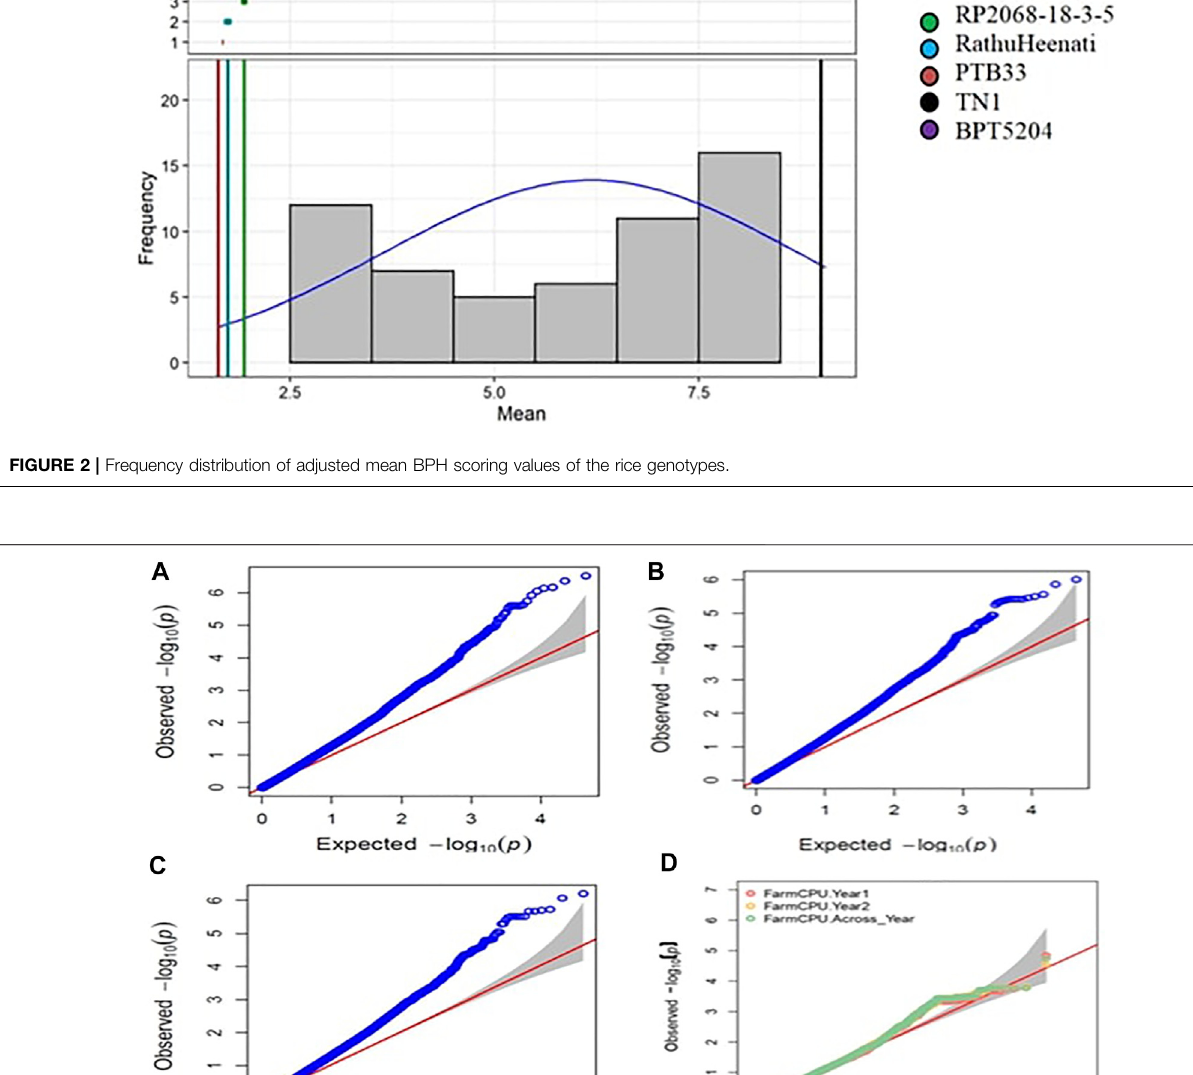
Frontiers in Genetics |